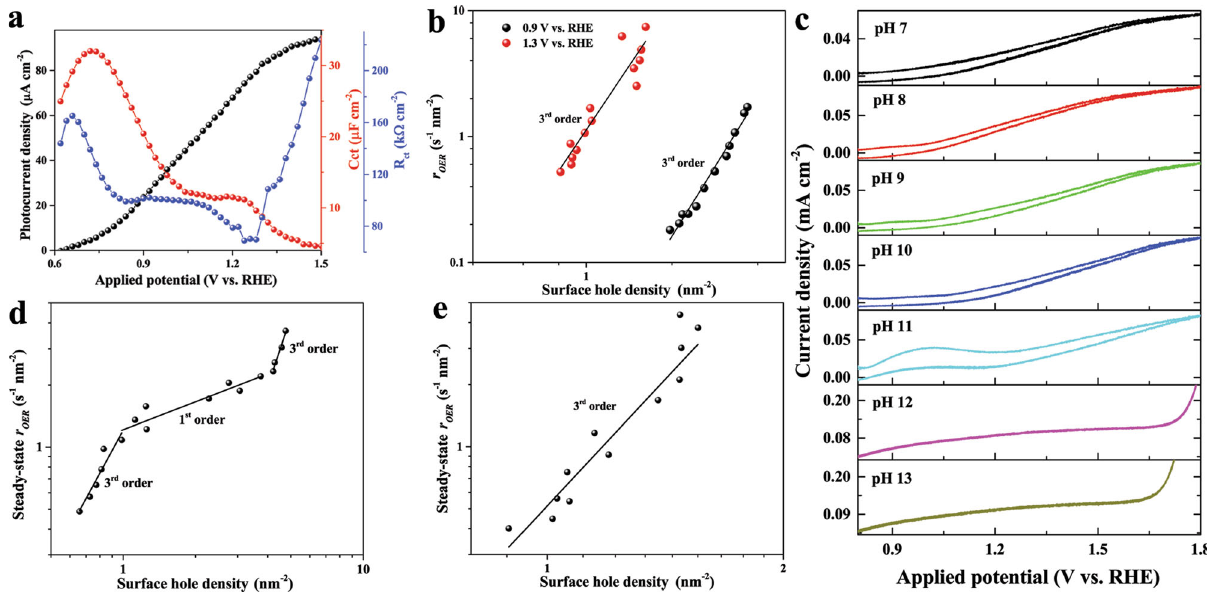
Fig. 3 Effect of electrolyte pH on the dynamic interplay of S1 and S2. a Evolution of J – V (black), surface state capacitance ( C ct , red) and charge transfer resistance ( R ct , blue) as a function of the applied potential (illumination intensity: 100 mW cm − 2 , pH 13.0). b Rate law analysis at 1.3 and 0.9 V vs. RHE (pH 13.0) where S1 and S2 gain maximum values. c CV pro fi les (illumination intensity: 100 mWcm − 2 , scan rate: 5 mV s − 1 ) of a hematite photoanode measured in different electrolyte pH (unbuffered). Rate law analysis at 1.3 V vs. RHE in pH 11.0 where S1 reaches maximum values without ( d ) and with buffer ions ( e ). Steady-state OER rate ( r OER ) and surface hole densities were probed by intensity-modulated